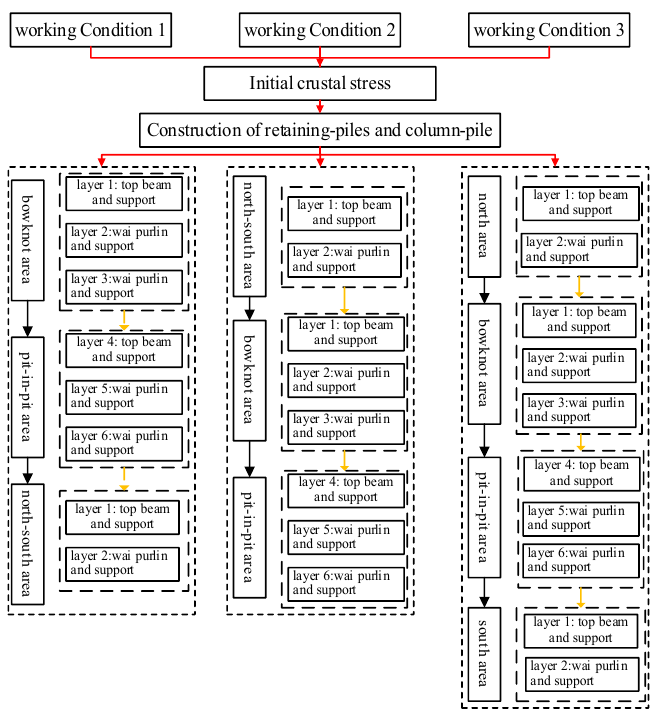
Figure 8. The analysis steps of step-by-step partitioned excavation method.